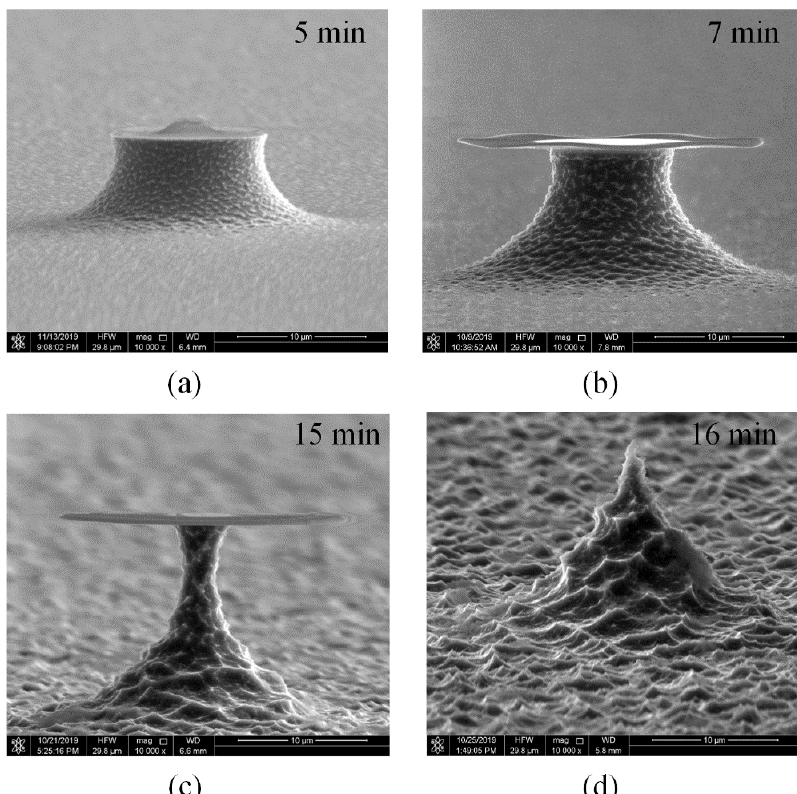
Figure 3. The tip profiles after etching for different duration with the same recipe: pressure is 3 mTorr, flow rate is 20 sccm, ICP power is 1000 W and platen power is 0 W. ( a ) 5 min, ( b ) 7 min, ( c ) 15 min, ( d ) 16 min.